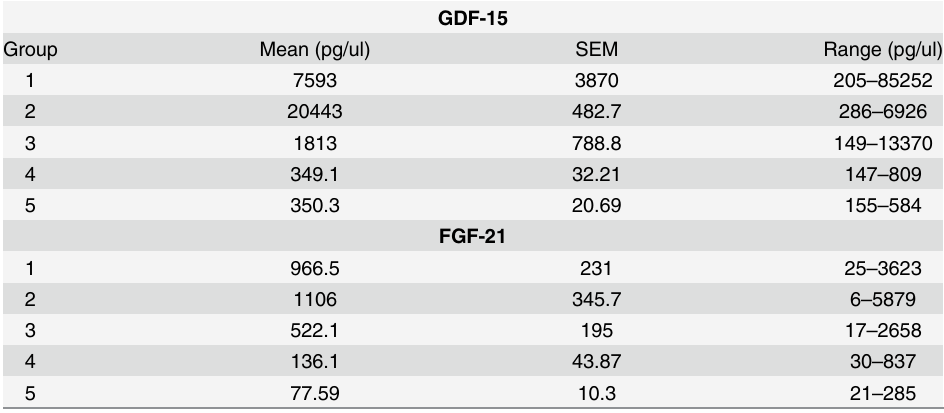
Table 1. Serum concentration of GDF-15 and FGF-21 in patients and controls.